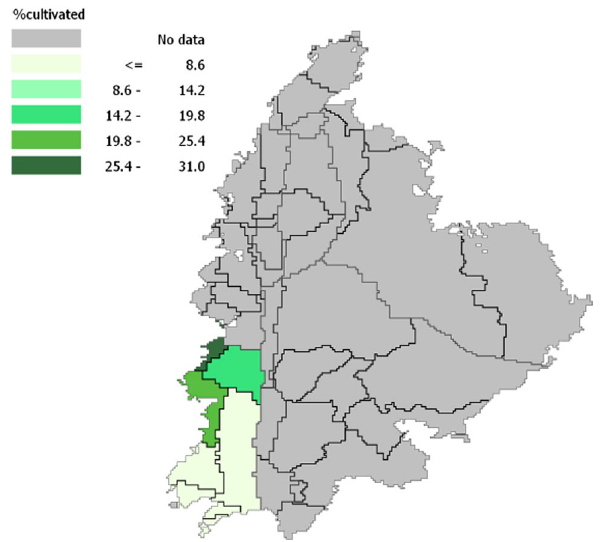
Fig. 2 Location of study area within the